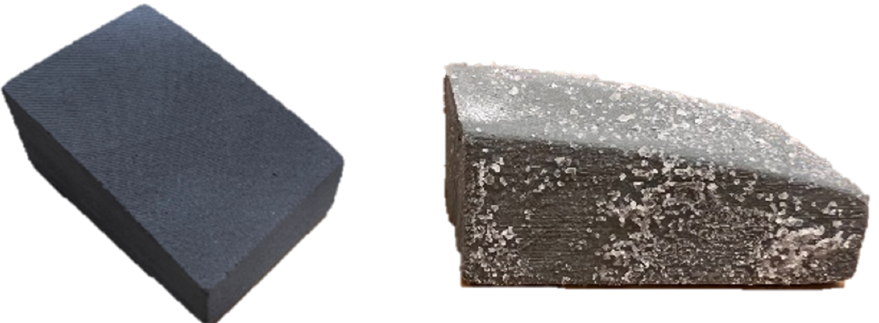
Figure 3. Silicon carbide sample as printed ( left ) and after cyanoacrylate infiltration ( right ) [19].